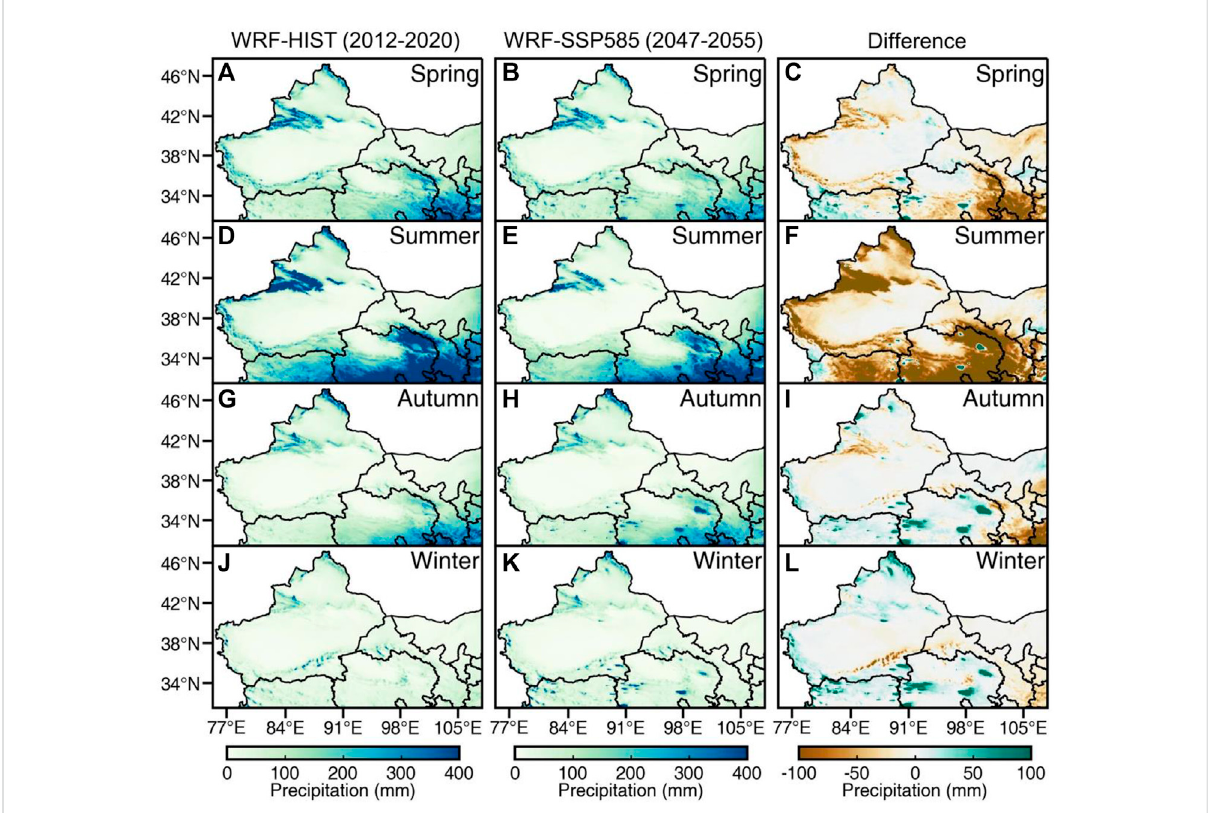
FIGURE 6 Multi-yearseasonalaverageprecipitationprojectedchangessimulatedbyWRF-HIST(2012 – 2020)andWRF-SSP585(2047 – 2055)experiments over Northwest